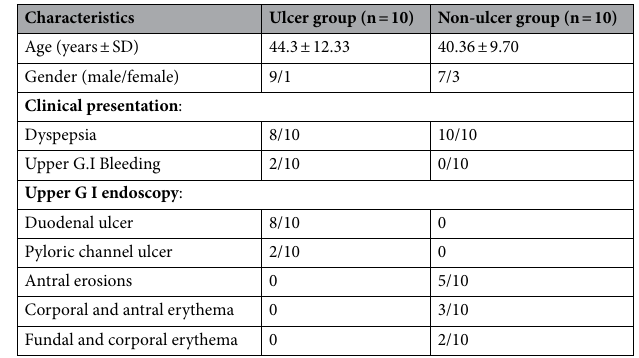
Table 1. Demographic and clinical characteristics of the study